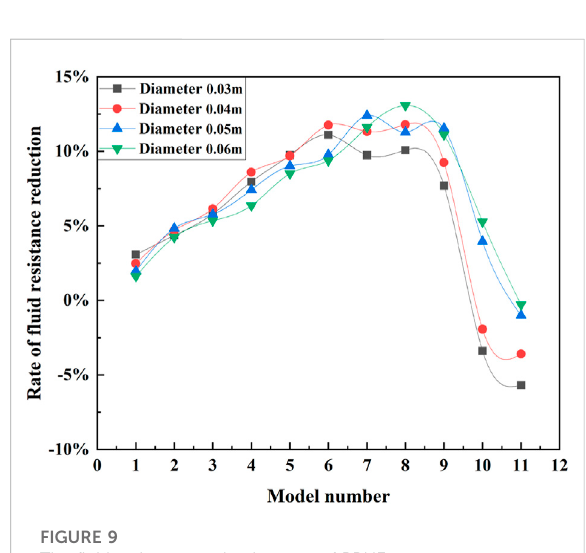
FIGURE 9 The fl uid resistance reduction rate of